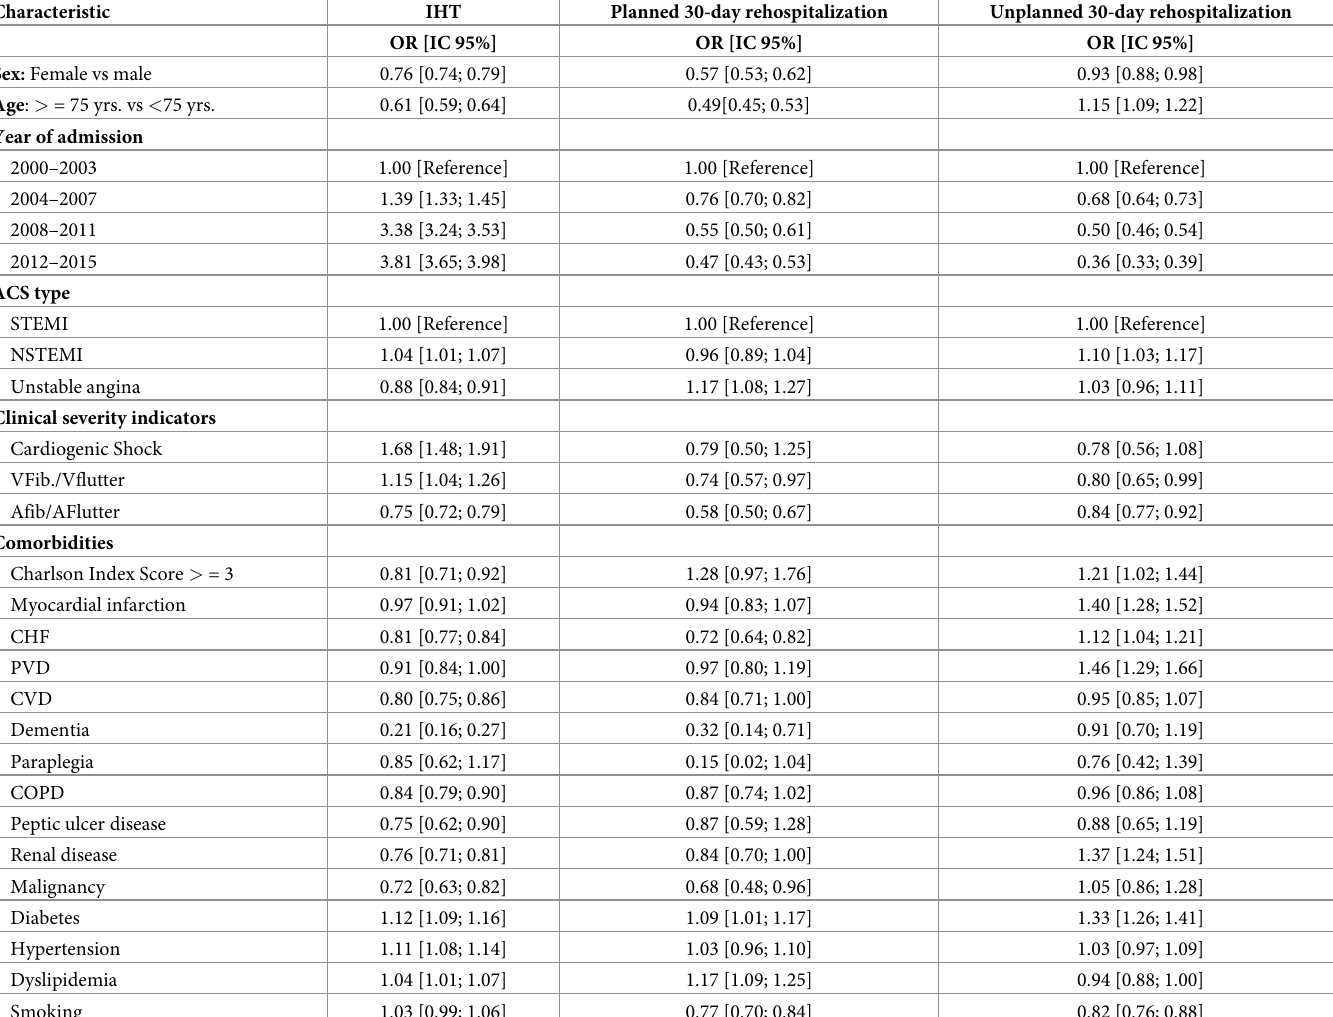
Table 2. Estimated odds ratios [95% confidence intervals] for the multivariable multinomial logistic model with single hospitalization ACS-EC as reference cate- gory and adjusted for first contact hospital characteristics (PCI capability, size and case-mix index). Characteristic